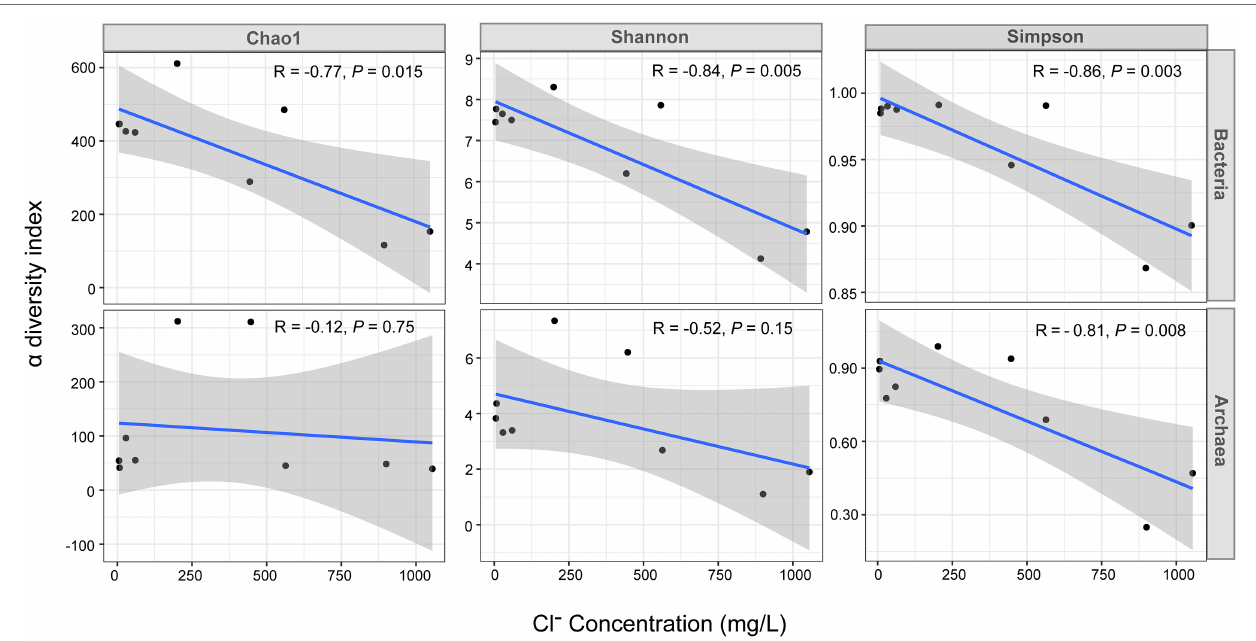
FIGURE 3 | Pearson correlation analysis between the Cl − concentration and the α diversity indices of bacteria and archaea. The x -axis represents the Cl − concentration (mg/L) and the y -axis represents the α diversity index value. The R and value of p in the plot were obtained by Pearson correlation analysis, the solid blue line is the linear regression fit curve and the shaded areas represents the 95% confidence intervals. The data of nine samples including the high tide samples of G1 monitoring sites and the high tide samples of the G2 and G3 were used for this analysis.